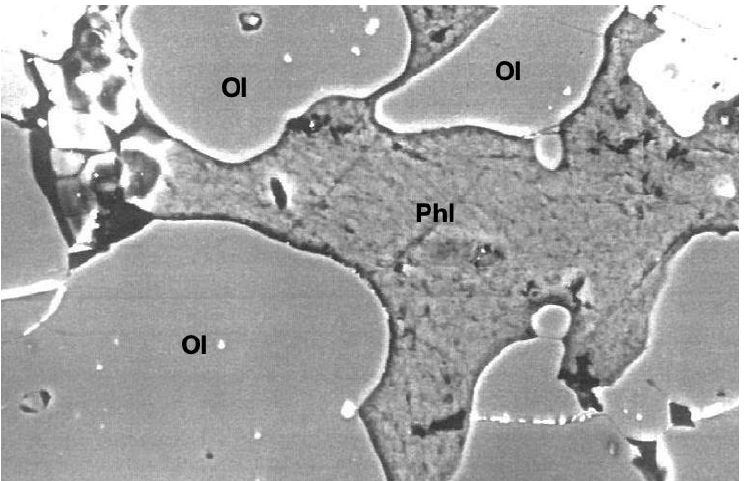
Figure 2. Back-scattered electron image of the peridotite section after Experiment G128 at 2 GPa and 1125 °C (Ol+Cpx+Phl). Compositionally homogeneous xenomorphic phlogopite crystallizes interstitially between olivine and clinopyroxene. Olivine shows rounded and embayed grains indicating reaction (Melt + olivine => Phl) and light, Fe-rich rims due to approaching equilibrium of Mg# with the infiltrating melt.